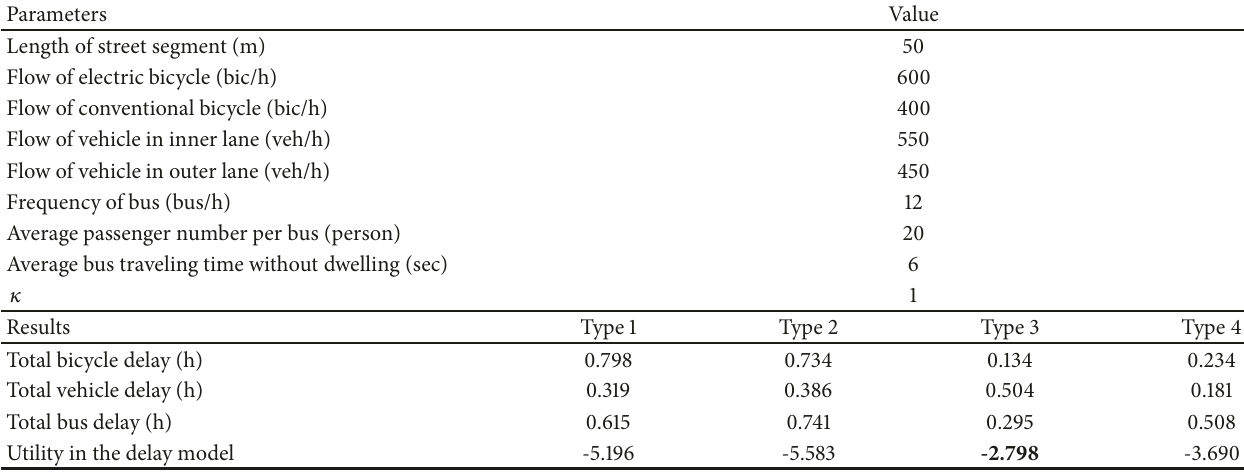
Table 4: Procedure for bus stop